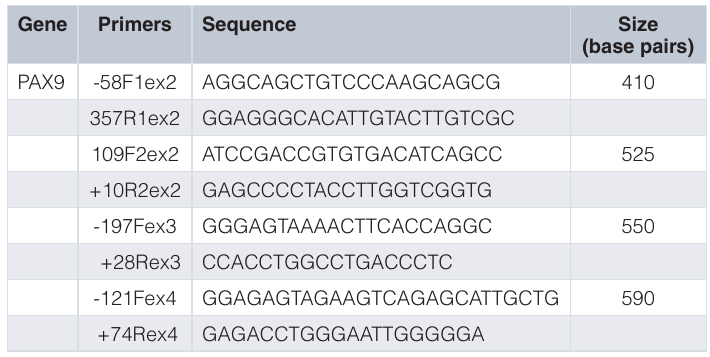
Table 1. Primer sequences used in this